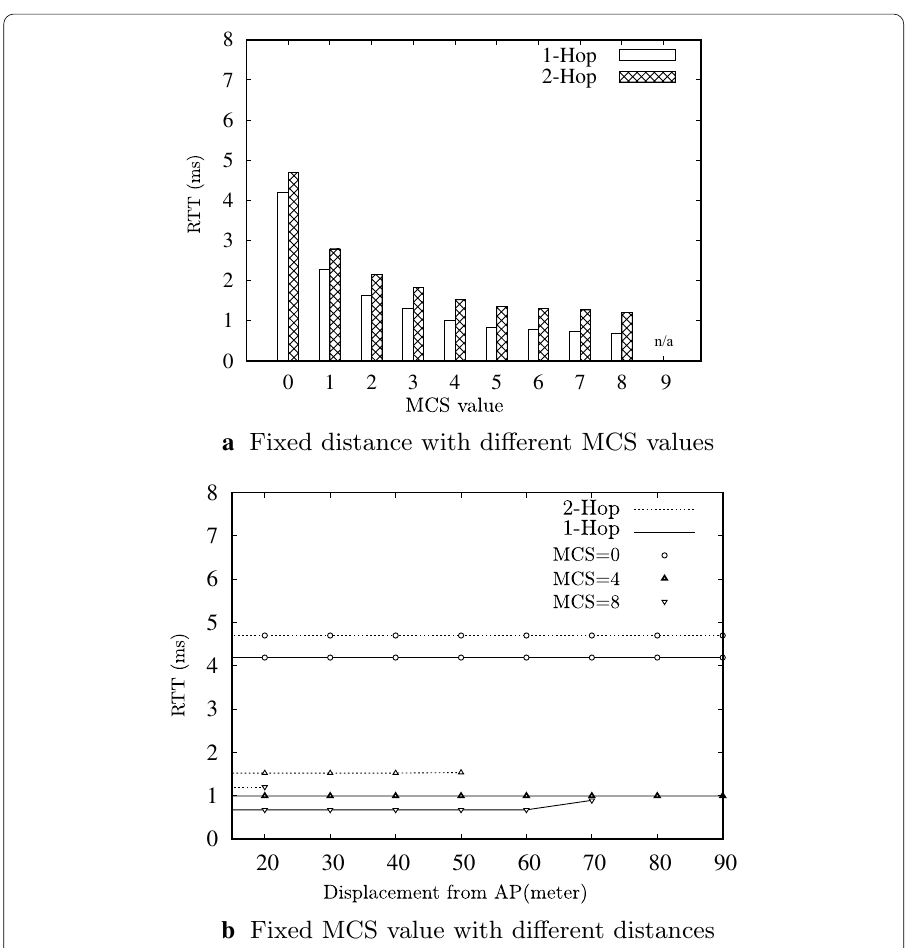
Fig. 7 Effect of MCS and distance on RTT